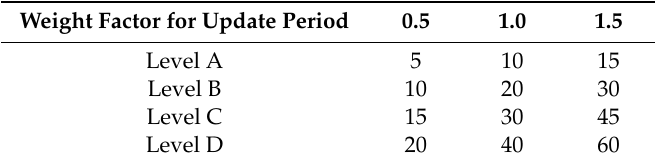
Table 3. Score increase criteria by each level according to the whitelist update period.